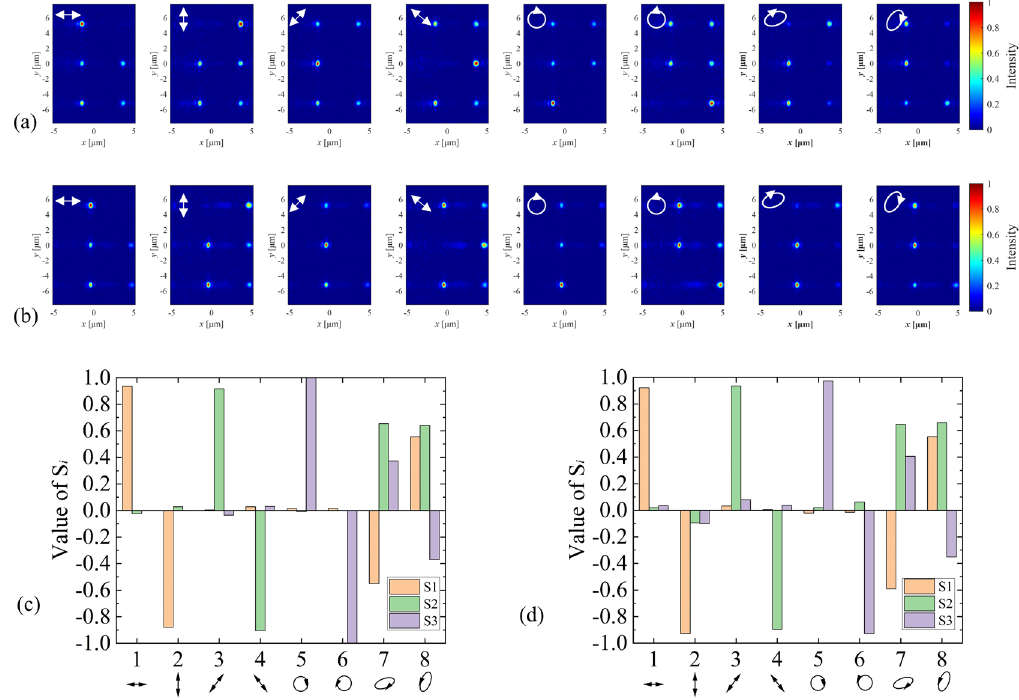
Figure 5. The intensity distributions of different incident polarization states at ( a ) − 10° and ( b ) − 20°. The calculated normalized modified Stokes parameters of different polarization states at incident angles of ( c ) − 10° and ( d ) − 20°.